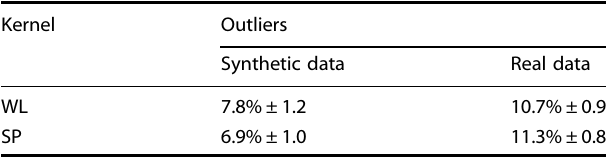
Table 4. Percentage of real and synthetic samples that were identi fi ed as outliers by the one-class SVM algorithm.